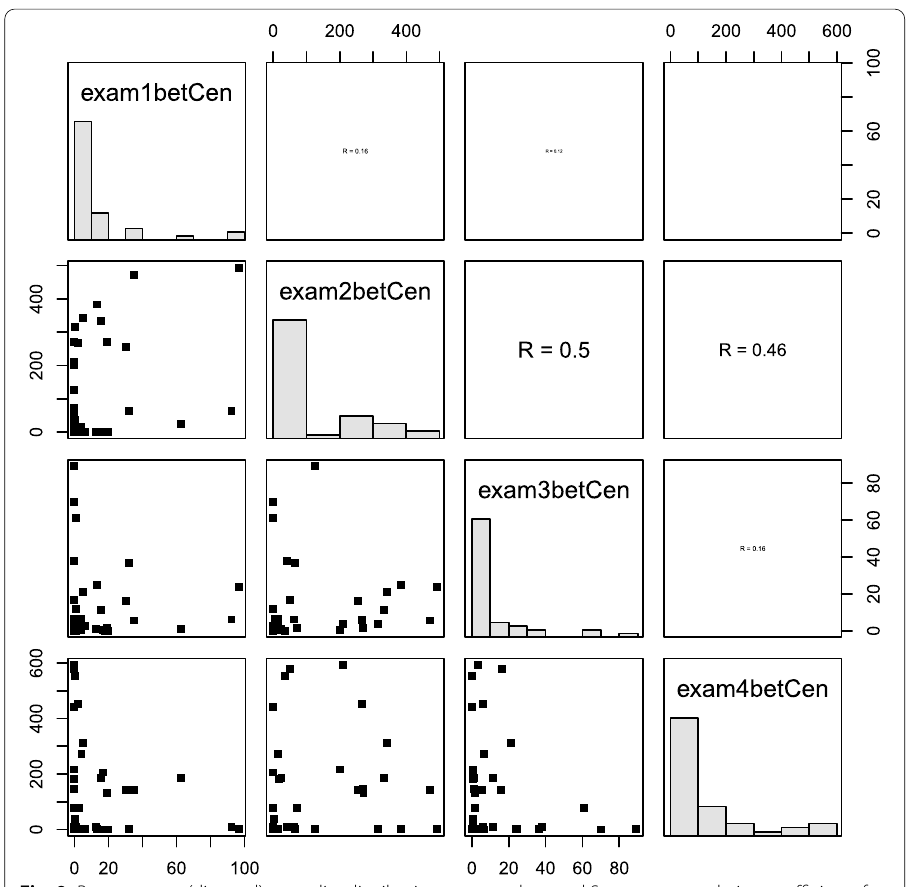
Fig. 9 Betweenness (directed) centrality distributions, scatterplots, and Spearman correlation coefficients for the Fall 2015 exams